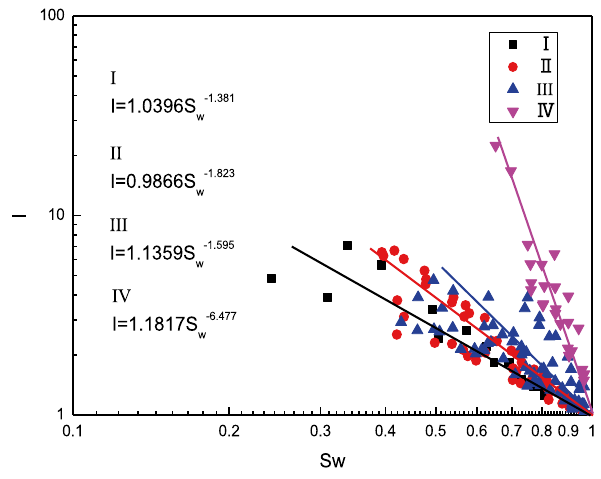
Fig. 11 I – S w relationship of different pore structure